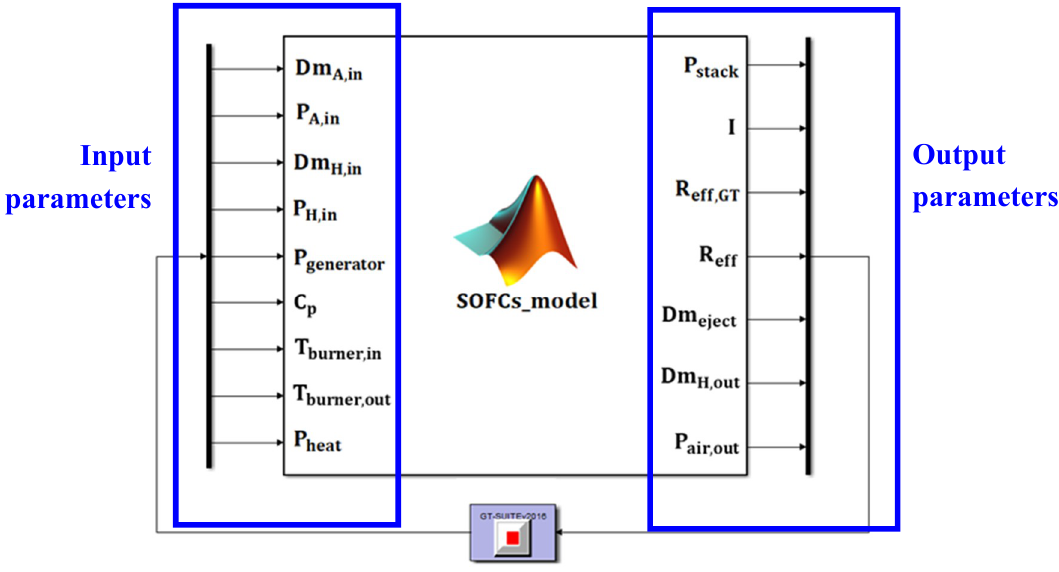
Figure 4. MATLAB/SIMULINK diagram of the 5 kW solid oxide fuel cells (SOFCs) stack.